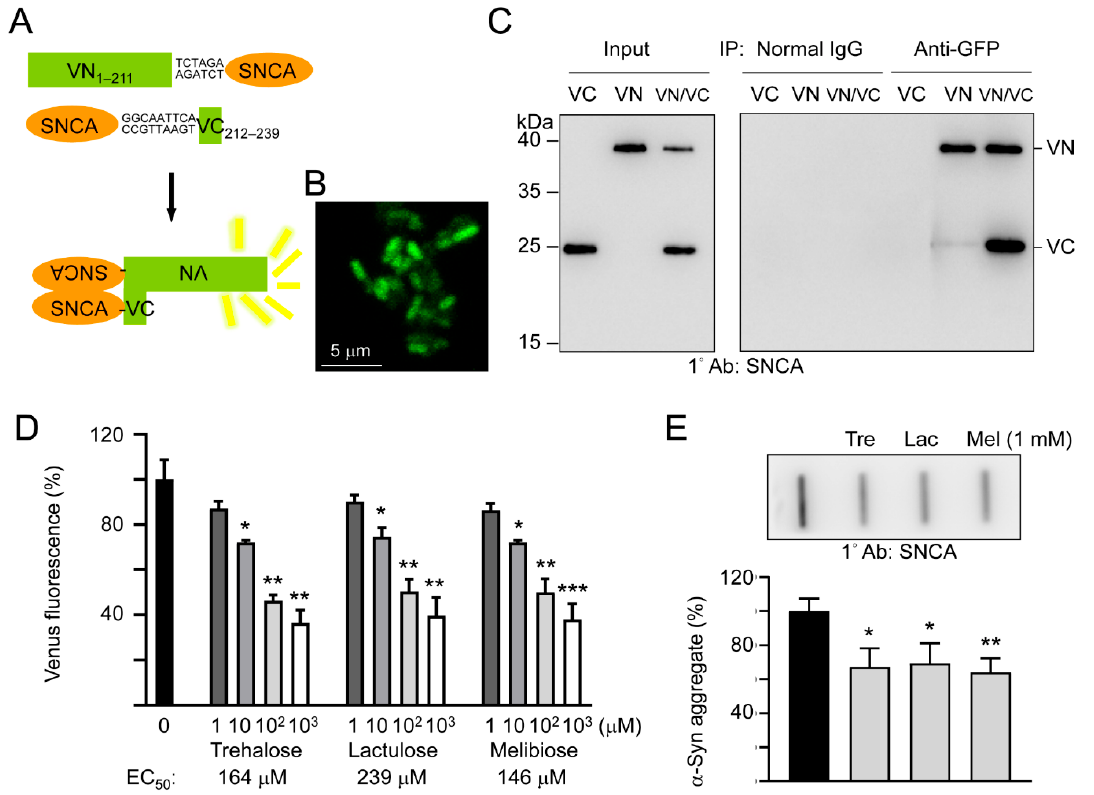
Figure 3. Split Venus BiFC assay of trehalose and analogs. ( A ) Schematic representation of VN 1–211 -SNCA and SNCA-VC 212–239 fusion proteins and interaction between two fused α -synuclein facilitating reassembly of fluorescent Venus protein (VN, Venus N-terminal 1–211 amino acids; VC, Venus C-terminal 212–239 amino acids). Shown between SNCA and Venus fragment is nucleotide sequence of 2–3 amino acid-linker. ( B) Confocal microscopy image of E. coli cells displaying complementary Venus fluorescence. ( C ) Co-immunoprecipitation of VN 1–211 -SNCA and SNCA-VC 212–239 with anti-GFP antibody. Bacterial cell lysates from cells transformed with VN 1–211 -SNCA (VN), SNCA-VC 212–239 (VC), and VN 1–211 -SNCA / SNCA-VC 212–239 (VN / VC), respectively, were prepared (Input, left panel) and immunoprecipitations (IP, right panel) were performed with anti-GFP antibody. Normal IgG was